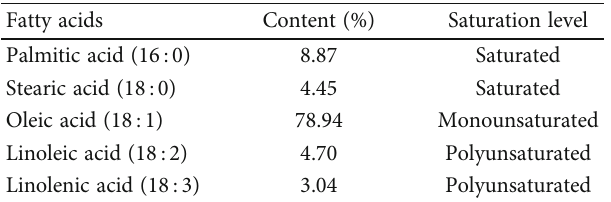
Figure 1: General equation of the transesteri fi cation reaction. Table 1: Fatty acid composition of Podocarpus falcatus oil